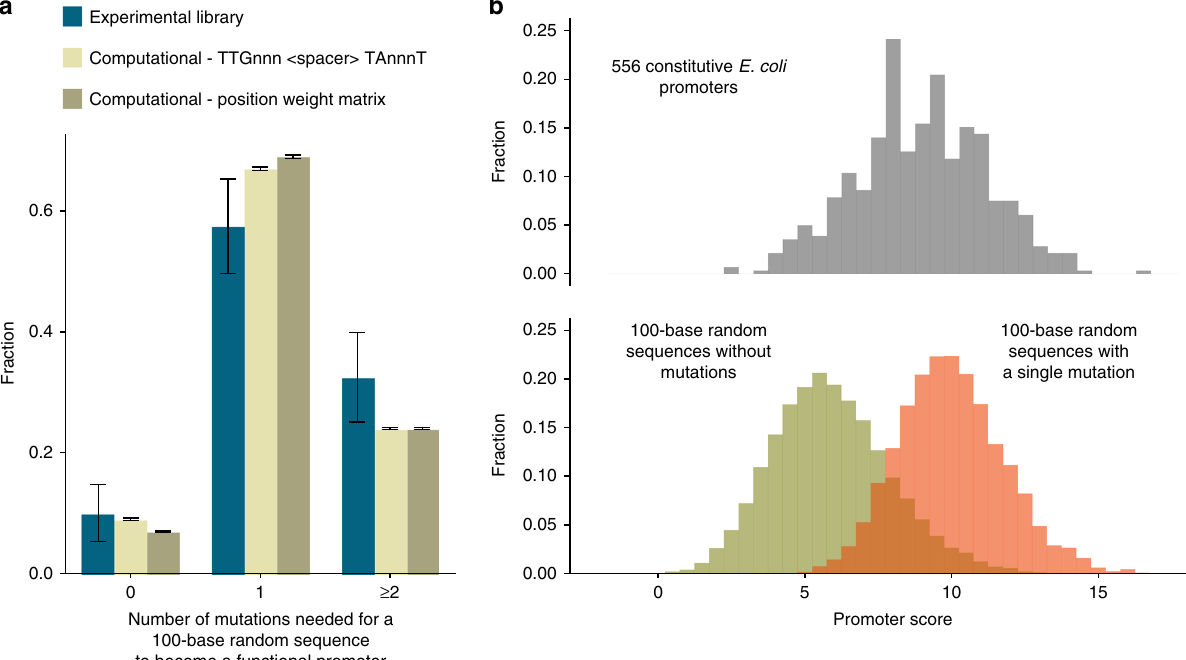
Fig. 4 The mutational distance from a 100-base random sequence to a promoter. a The number of mutations needed to transform a random sequence to a functional promoter. The experimental results from the evolution library ( n = 40) are shown in blue, zero represents random sequences that were active already before any adaptation and ≥ 2 represent random sequences that require two or more mutation in which we include all the library strains that could not evolve expression via mutations in the random sequences. Computationally generated sequences ( n = 30,000) were scanned for their resemblance to a canonical promoter and were mutated in silico until they pass our criterion for a promoter. We used two different criteria: the ability to capture the most important bases in the − 10 and − 35 promoter motifs TTGnnn and TAnnnT, with a valid spacer (light green), and the ability to score as the median score of E. coli WT constitutive promoters, according to a position-speci fi c weight matrix score (olive). Both criteria yield similar results to those of our experimental library (error bars represent s.d.). b Comparing promoter scores according to a position-speci fi c weight matrix. Upper panel shows a histogram of scores for E. coli constitutive promoters ( n = 556). Lower panel shows a histogram of scores for random generated sequences ( n = 30,000), before in silico evolution (olive), and after the fi rst mutation selected (orange). The overlap between the scores of the constitutive promoters to those of the random sequences (before evolution) suggests for our experimental observation of the fraction of random sequences that are already active promoters. The overlap between the scores of the constitutive promoters to those of mutated random sequences strengthen our experimental result that a random sequence of ~100 bases is typically one mutation away from functioning as a promoter. Data from these histograms were the base for the data shown